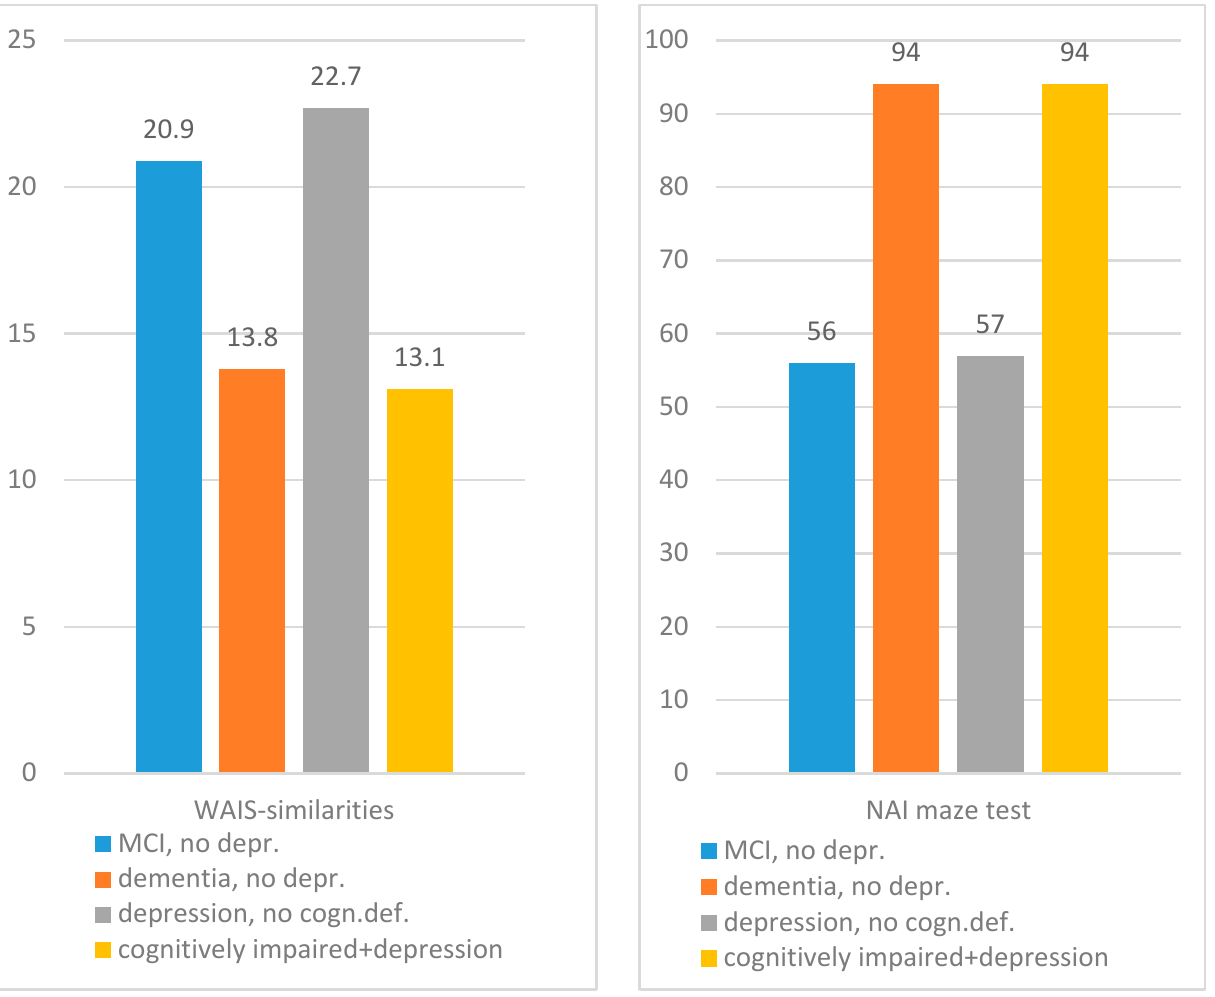
Figure 1. SKT and RBMT: diagnosis groups.